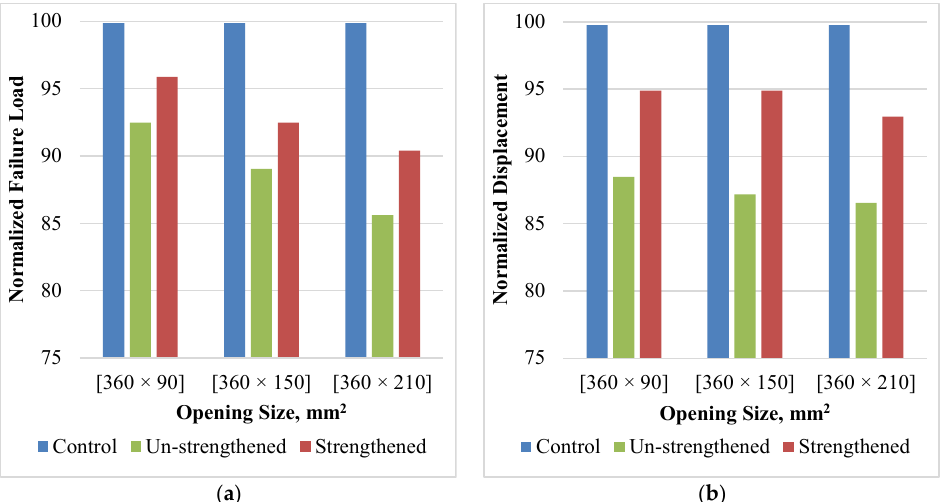
Figure 6. Effect of Strengthening and Tension Zone Opening Size. ( a ) failure load; ( b ) failure displacement.